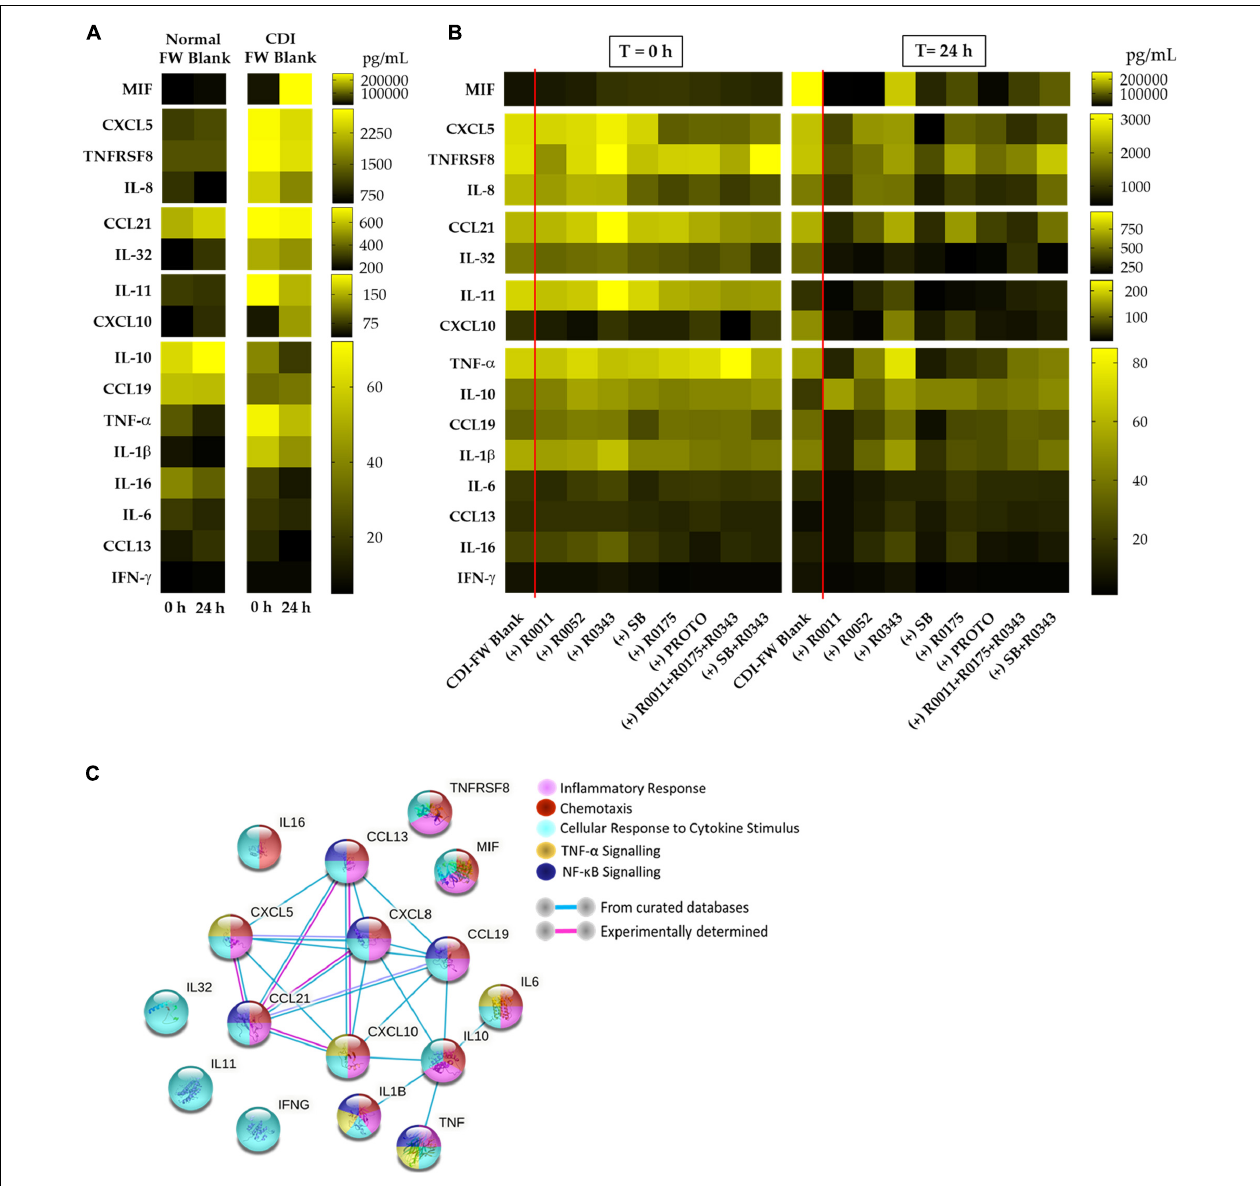
FIGURE 2 | Cytokine and chemokine profiles from T84 cells exposed to the different fecal water (FW) treatments (collected at T = 0 h and T = 24 h from the batch fermentation) for a period of 8 h. (A) Cytokine and chemokine profiles in normal FW blank and CDI-FW blank. (B) Cytokine and chemokine profiles in CDI-FW supplemented with probiotic treatments. Data shown are the mean cytokine/chemokine production (picograms per milliliter; n = 4). (C) STRING v 11.0 analysis showing functional links between each of the different cytokines/chemokines produced. R0011 = L. rhamnosus R0011; R0052 = L. helveticus R0052; R0343 = L. rhamnosus GG R0343; SB = S. boulardii CNCM I-1079; R0175 = B. longum R0175; PROTO = ProtecFlorTM; R0011 + R0052 + R0175 = combination of L. rhamnosus R0011, L. helveticus R0052 and B. longum R0175; R0343 + SB = combination of L. rhamnosus GG R0343 and S. boulardii CNCM